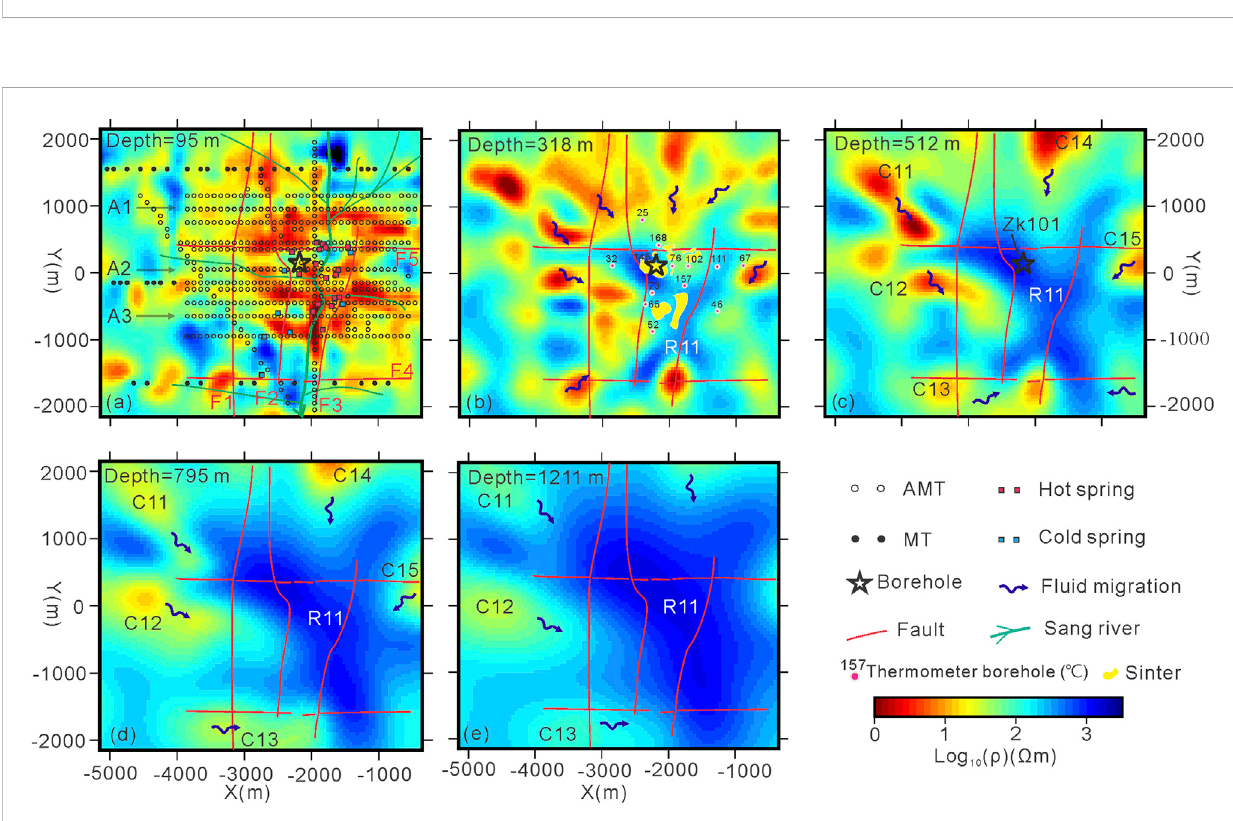
FIGURE 3 Horizontal slices of electrical model at different depths revealed by AMT. (A – E) Horizontal slices at depths of 95 m, 318 m, 512 m, 795 m, 1,211 m, respectively. The electrical model has the characteristics of high conductivity in the shallow depth (A – C) and high resistivity in the deep depth (D – E) . Thermometer boreholes with depths of 57.1 – 83.1 m give out temperatures at the bottoms, as shown in Figure